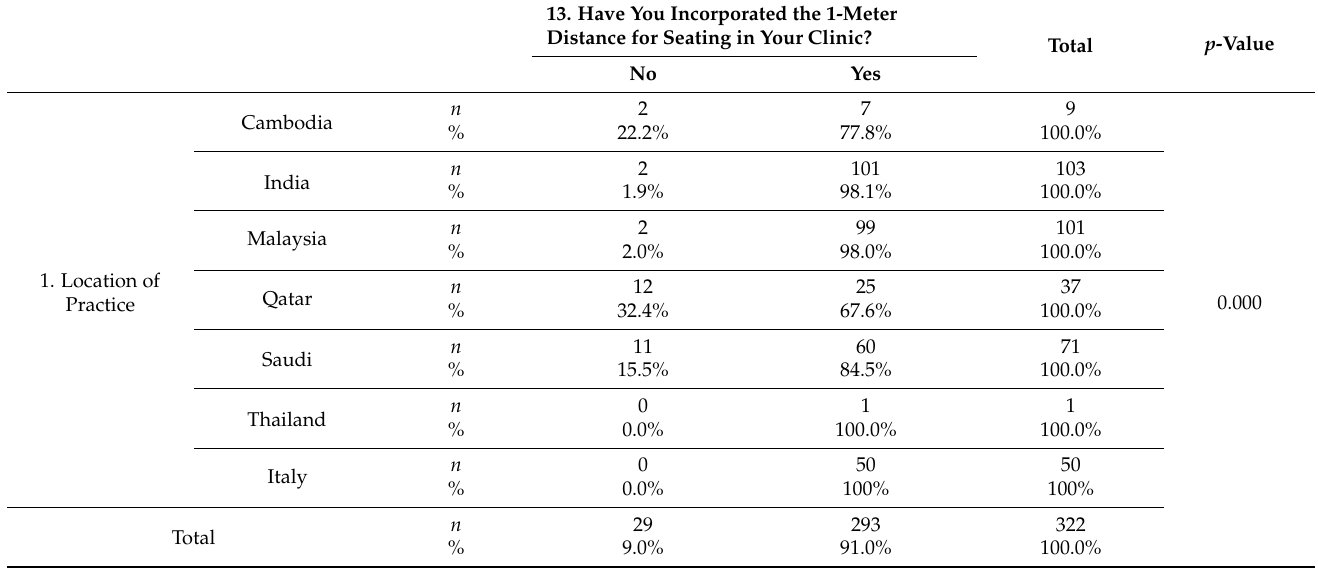
Table 3. Differences between dentists from various countries for the implementation of the 1-meter spaced seating in their